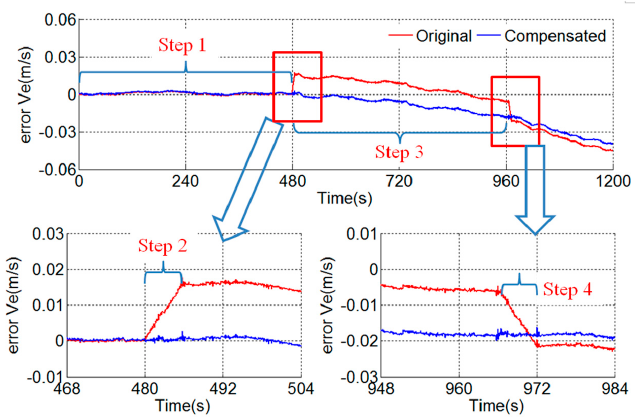
Figure 14. Result of compensation of asynchrony between gyroscope and accelerometer.